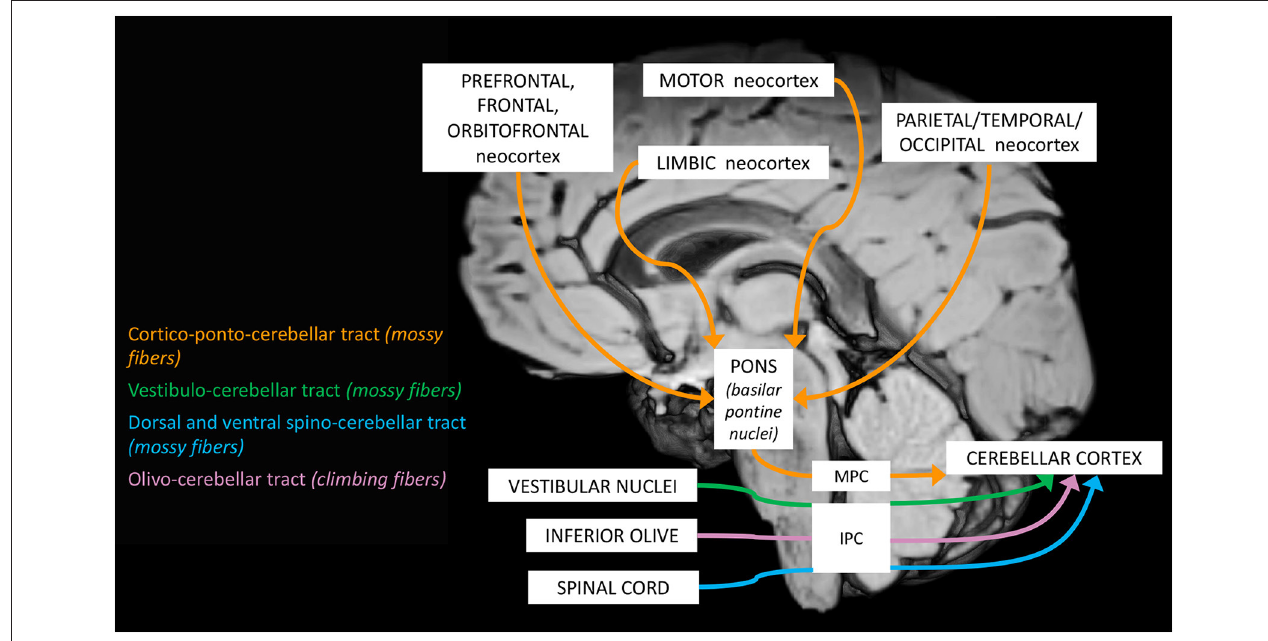
FIGURE 1 | Schematic representation of the main cerebellar afferent pathways.